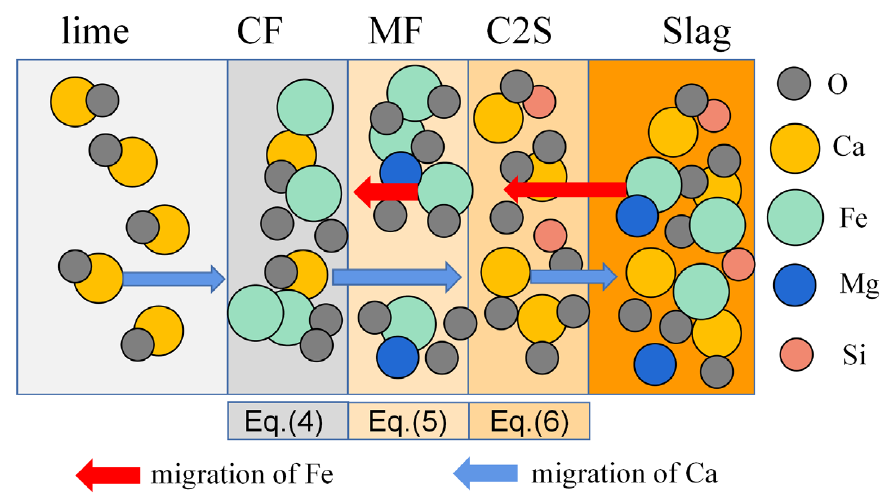
Figure 10. Diagram of the dissolution process of the lime column.